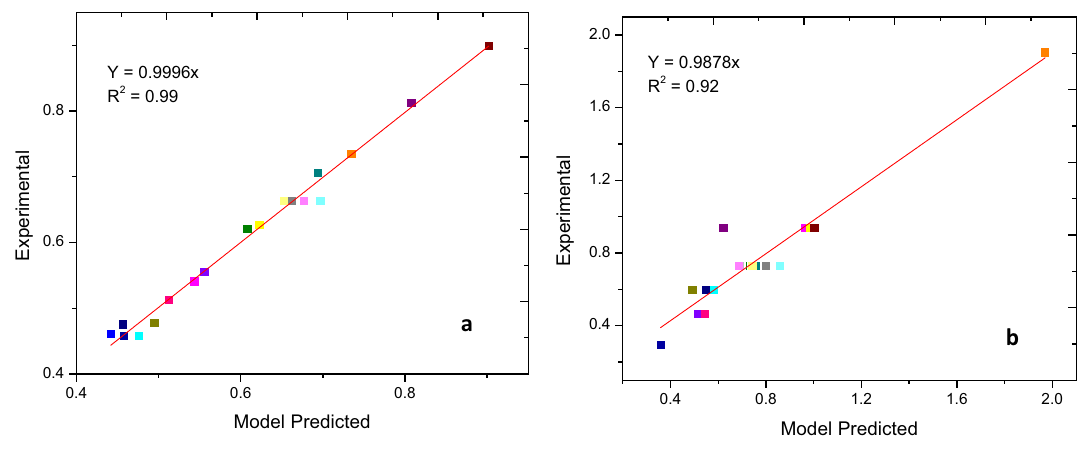
Fig. 2 Comparison between experimental and the model predicted data of a MFomax/SiO